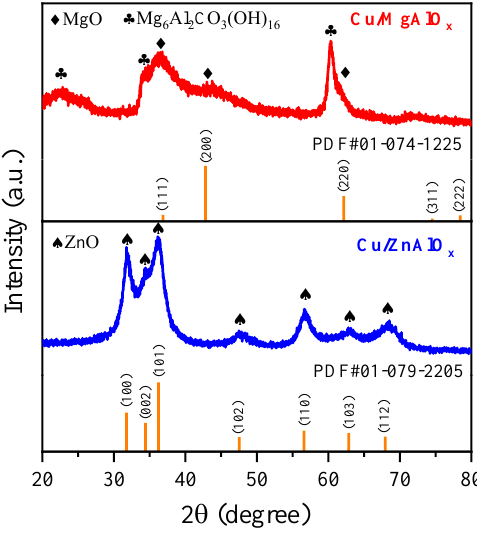
Figure 3. XRD patterns of different supported Cu catalysts.